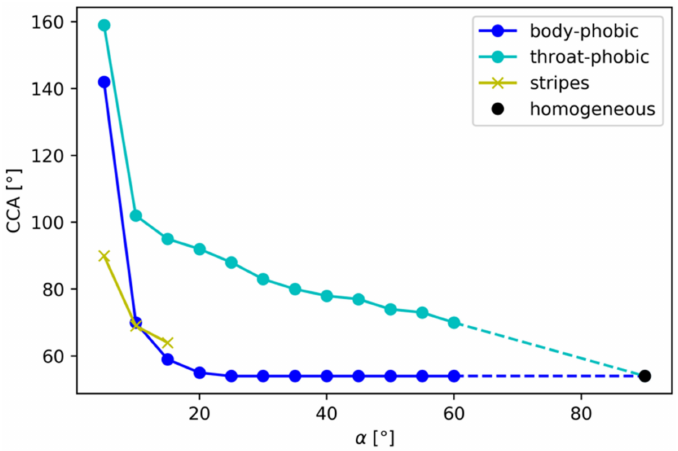
Figure 19. CCA for all coatings as a function of α